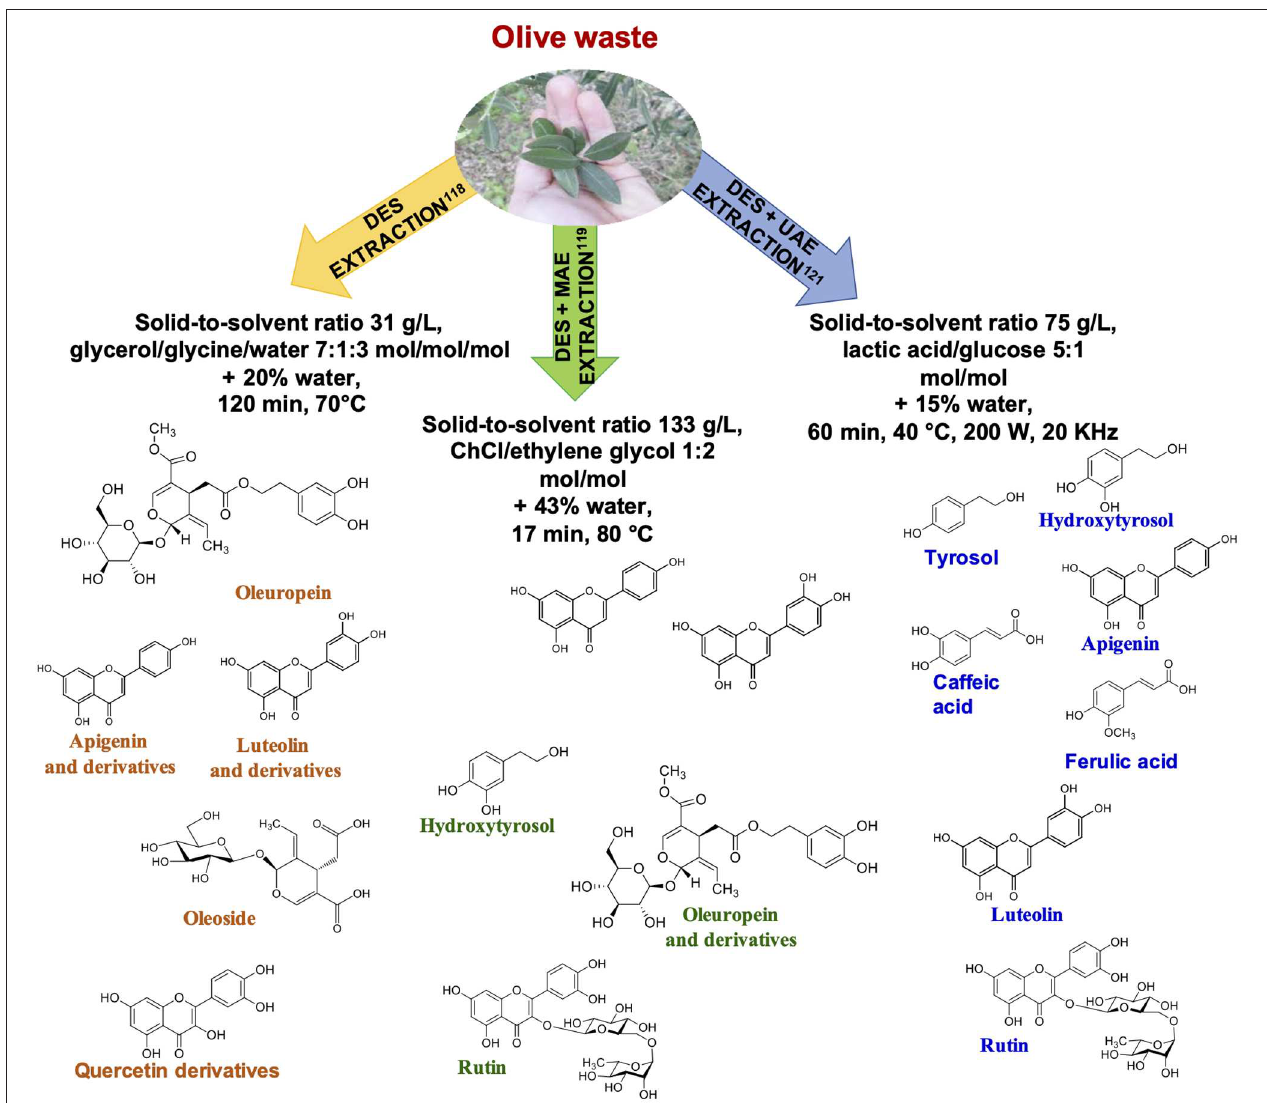
FIGURE 8 | Representative examples of phenolic compounds recovered from olive byproducts.